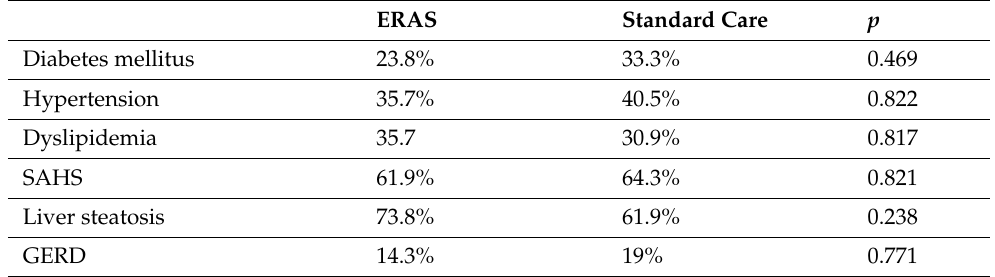
Table 2. Distribution of pathologies within the personal history between groups. (Chi-square test).